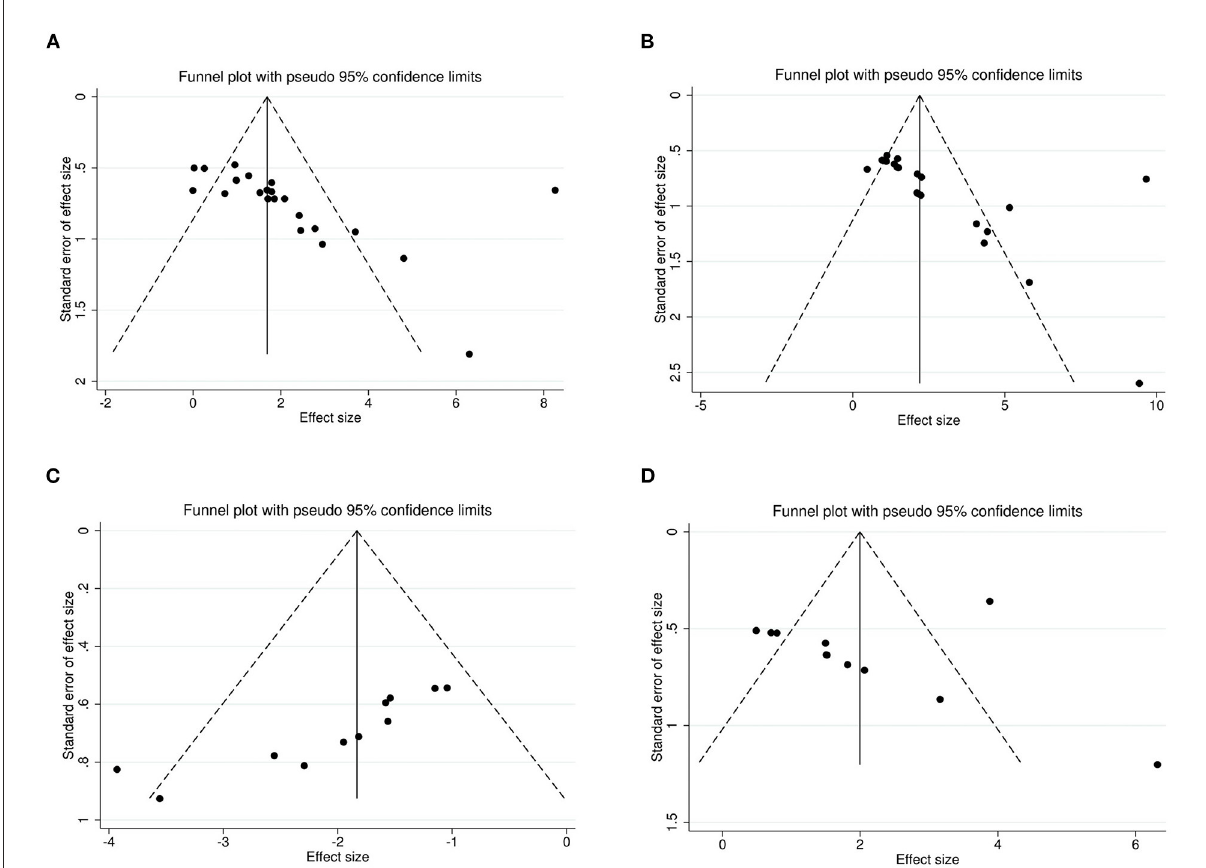
FIGURE9 Funnel plots for the sucrose preference test (A) , open-field test (B) , forced swimming test (C) , and body weight (D) showing the publication